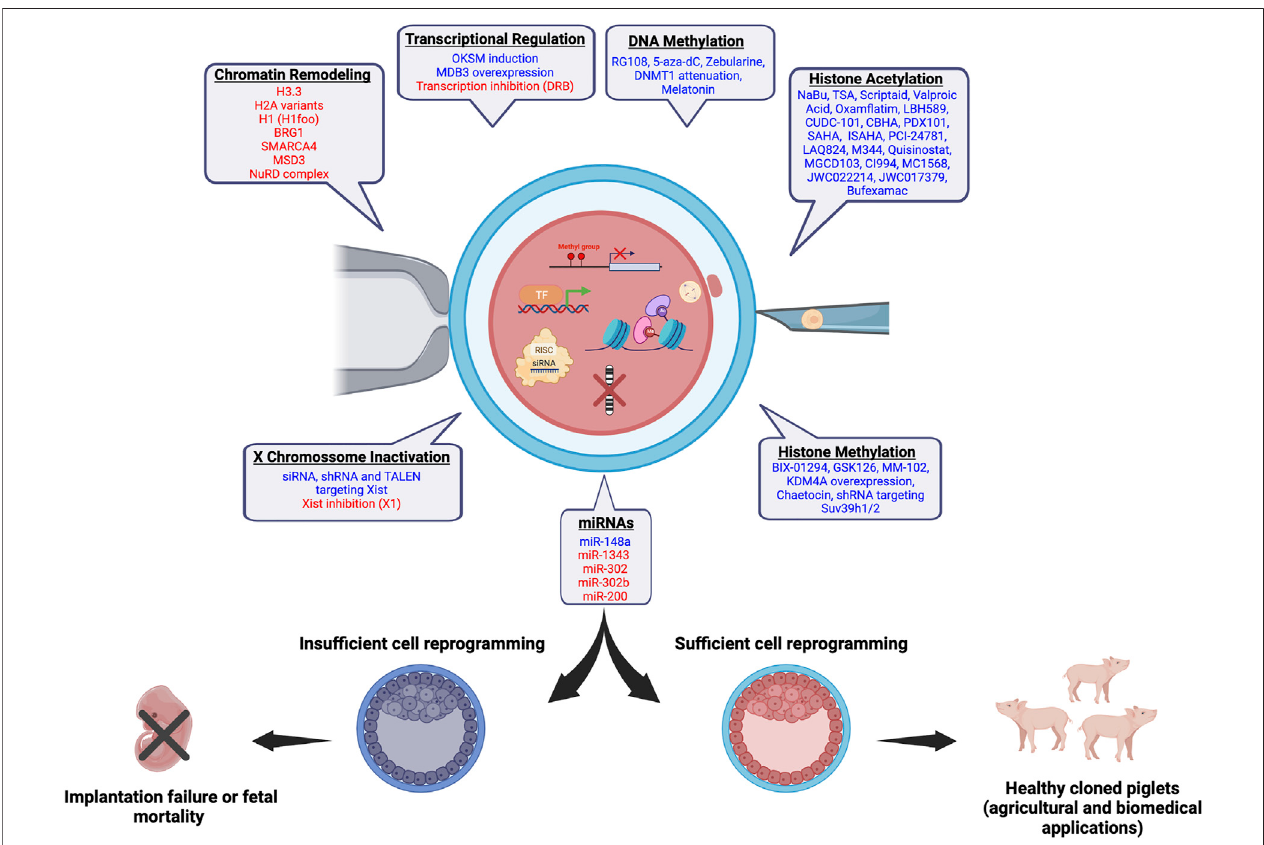
FIGURE1| Chromatin and epigeneticreprogrammingimpactingSCNT ef fi ciencyinpigs.Inblue, chromatin/epigenetic modi fi ersthathave beenpreviouslyshown to play a role on development of pig SCNT embryos and cloning ef fi ciency are listed. In red, modi fi ers that are believed to have a bene fi cial effect on the development of pig SCNT embryos based on studies in other species are listed. The fi gure was created with BioRender.com.